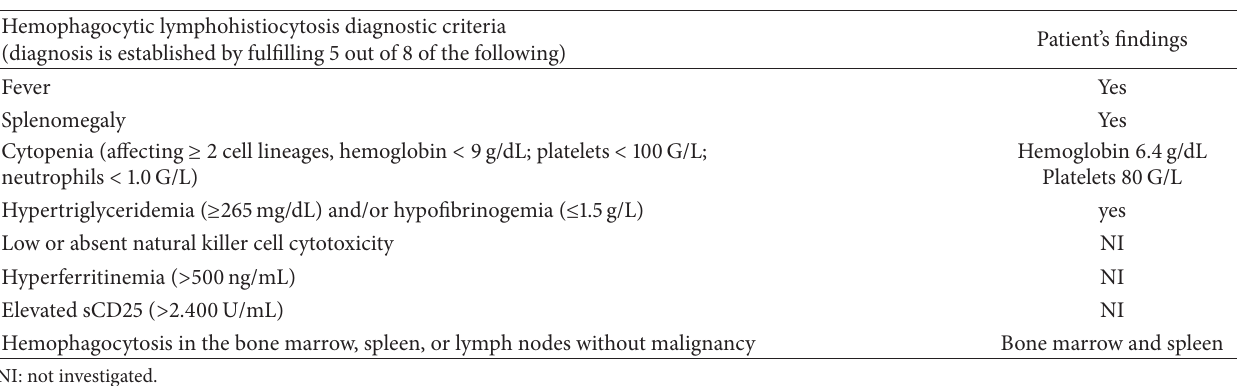
Table 3: Chronic granulomatous patients with Burkholderia cepaciacomplex infection and acquired hemophagocytic lymphohistiocytosis. Sex Age Mutation Site of infection M